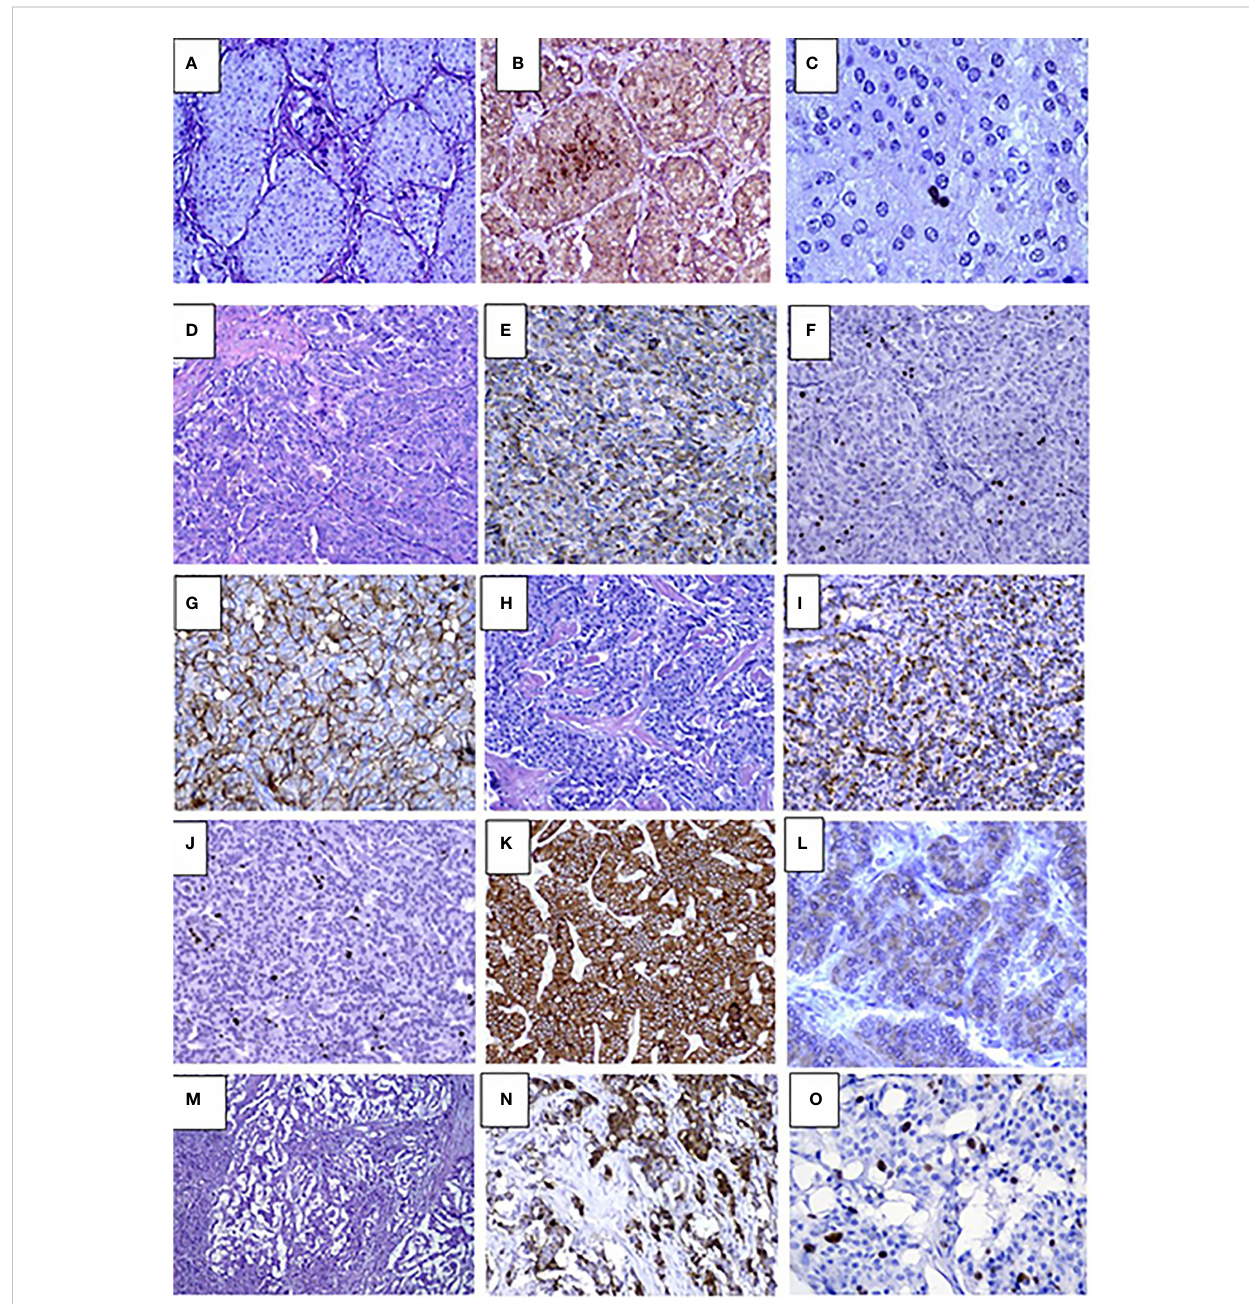
FIGURE 2 Pathology results in pediatric patients with insulinoma (A – C) . Case #10. Solid G1 insulinoma composed of packets of monomorphic cells, H&E, х 250 (A) , Immunohistochemistry staining with insulin shows abundance of insulin secreting cells within the lesion, х 250 (B) , Ki67 positive staining in single nuclei of tumor cells (1%) х 400 (C) . D-L. Case #4. Trabecular G2 insulinoma with poorly developed stroma, H&E, х 250 (D) , insulin staining, x250 (E) , Ki67 staining х 250 (F) , membrane expression of SSTR type 2 in tumor cells (3+), x250 (G) ; trabecular glucagon positive and insulin negative NET, G2, H&E, x250 (H) , moderate apical glucagon expression in tumor cells, glucagon staining x 250 (I) , Ki67 staining, x250 (J) , abundant membrane expression of SSTR type 2 (3+), x250 (K) , mild expression of SSTR type 5 (2+), x400 (L) , M-O. Case #12. Multifocal invasive insulinoma with trabecular architecture G2, H&E, x250 (M) , large complexes and small tumor cell nests expressing insulin, Insulin staining, x250 (N) , intensive Ki67 expression in cell nuclei, Ki67 staining, x400 (O)